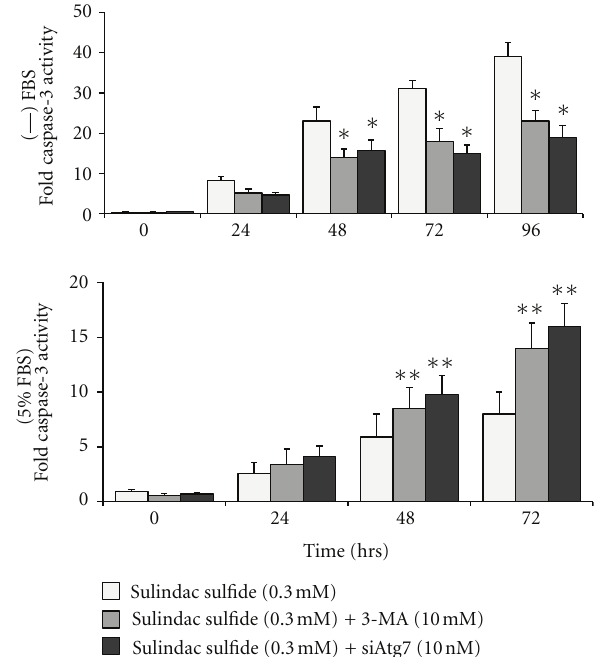
Figure 3: Autophagy inhibition reduced sulindac sulfide-induced apoptosis over time in serum-free media and increased sulfide- induced apoptosis over time in serum-containing media. HT-29 cells that were untransfected and transfected with control RNA and Atg7 siRNA were plated and treated as described in Figure 1. 3-MA was added to cell cultures 30 minutes prior to addition of sulindac sulfide. Apoptosis was determined by measuring fold caspase-3 activity. ∗ Indicates significant reduction in fold caspase-3 activity in cell cultures treated with autophagy inhibitors and sulindac sulfide relative to sulindac sulfide only, P < 0 . 01. ∗∗ Indicates significant increase in fold caspase-3 activity in cell cultures treated with autophagy inhibitors and sulindac sulfide relative to sulindac sulfide only, P < 0 . 01.